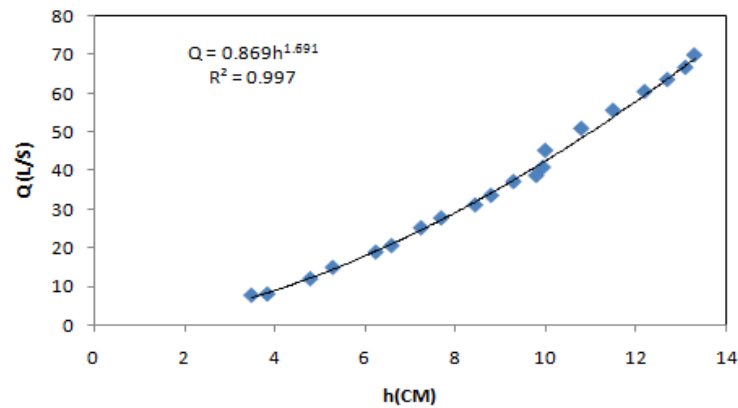
Figure 3. Calibration curve of the rectangular weir.